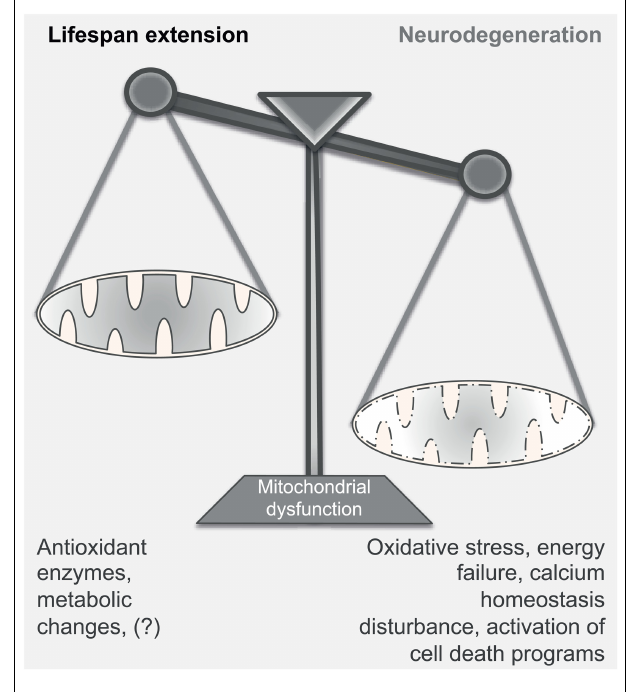
FIGURE 2 | Mitochondrial dysfunction in aging and neurodegeneration. Mitochondrial dysfunction can have either a positive or a negative effect on the normal function of the cell; mild mitochondrial dysfunction stimulates retrograde signaling, increasing – among others – the production of antioxidant enzymes and inducing metabolic changes. This adaptive response leads to the extension of the lifespan of the organism. On the contrary, severe disturbance of the mitochondrial activity may become detrimental for the survival of the cell, as it compromises energy production, induces oxidative stress and disturbs calcium homeostasis. Under these conditions, neurons undergo rapid changes of the dendritic structures and, according to the damage, can engage detrimental programs that cause cell death.Thus, strong